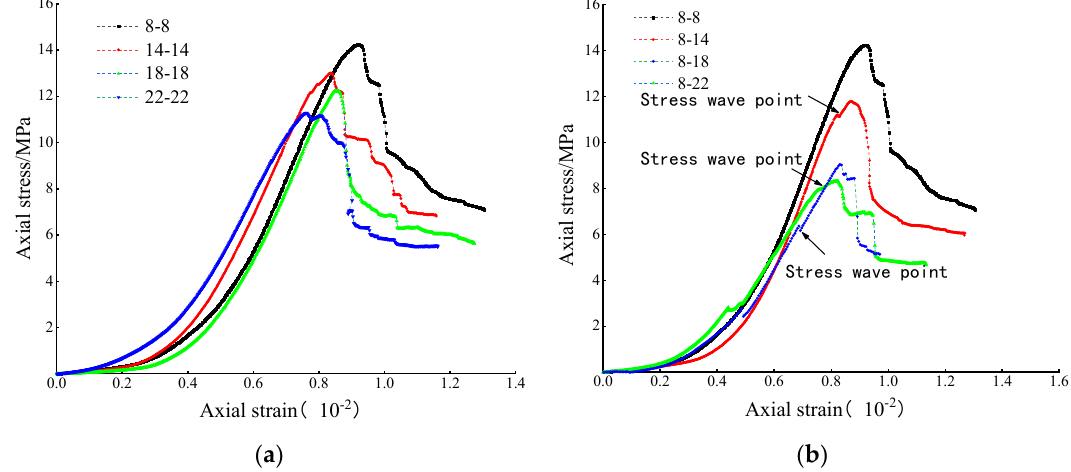
Figure 7. Stress–strain curve of drilled sample.: ( a ) is stress–strain curves for of the same − diameter drilling sample; ( b ) is stress–strain curves for of the variable − diameter drilling sample.